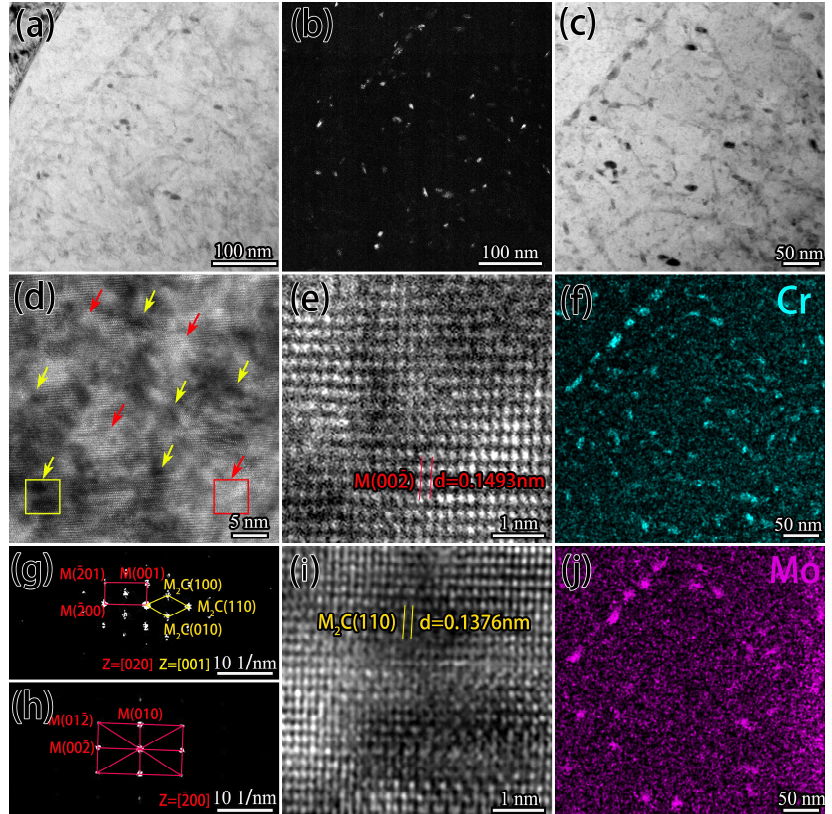
Figure 12. Carbides at 0.1 mm in the surface layer under L4 process: ( a , b ) bright- and dark-field image of carbides; ( c , f , j ) carbide-enriched areas and corresponding Cr and Mo elemental mapping analysis; ( d ) HRTEM of carbide-enriched areas; ( e , i ) HRTEM for the red and yellow regions of ( d ); ( g ) the FFT corresponding to figure; ( e , h ) the FFT corresponding to figure ( i ).